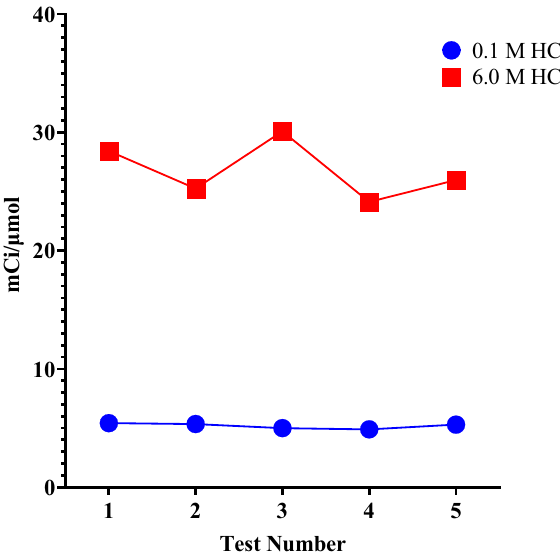
Figure 7. Apparent molar activity of 52 Mn as a function of the concentration of the elution